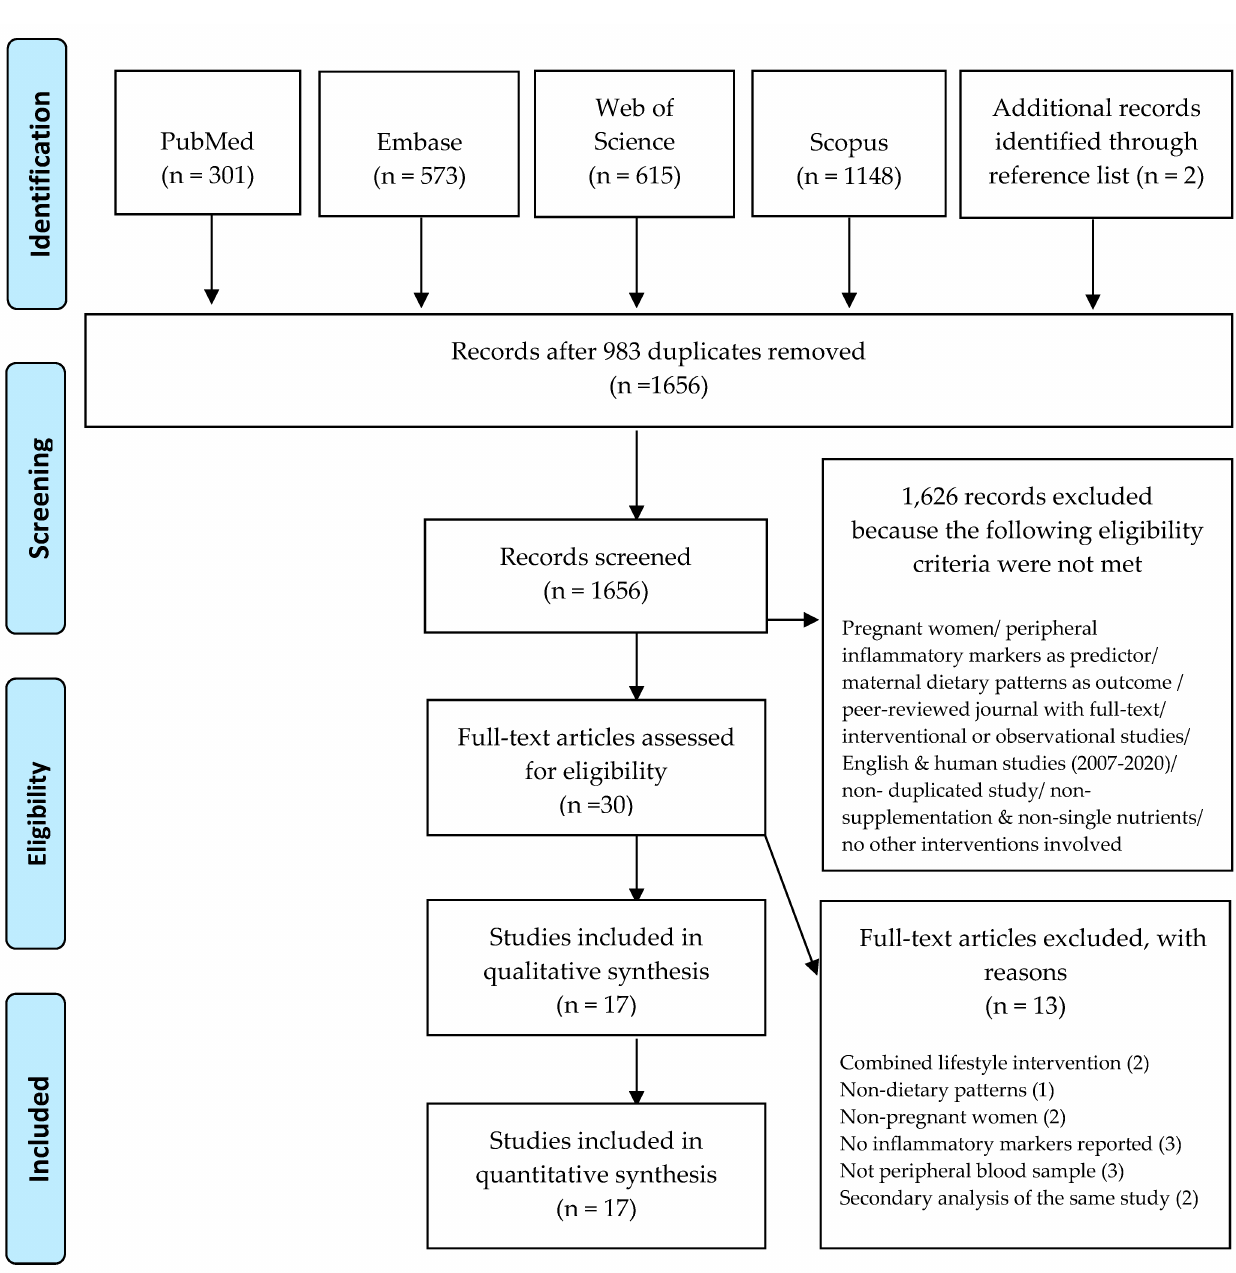
Figure 1. Literature was searched in September 2018 and updated in May 2020. The included studies were published from 2007 to May 2020.